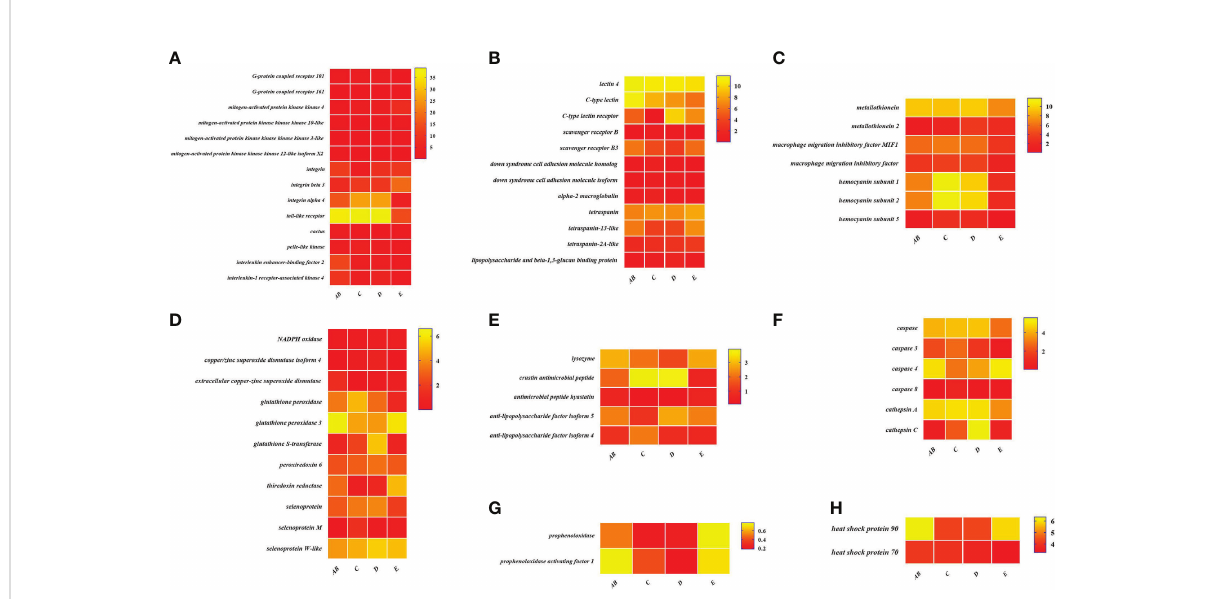
FIGURE 8 Expression patterns of immune-related genes in the hepatopancreas during the molting cycle of P. trituberculatus . (A) The genes related to signal transduction; (B) the genes related to pattern recognition proteins/receptors; (C) the genes related to other immune molecules; (D) the genes related to antioxidative enzymes system; (E) the genes related to antimicrobial peptides; (F) the genes related to apoptosis; (G) the genes related to prophenoloxidase cascade; (H) the genes related to chaperones. Notes: (1) The x -axis shows the molting stages, whereas the y -axis represents the name of genes. (2) The color represents the expression level of the gene; the lighter the color, the higher the gene expression level. (3) The expression level of immune-related genes was shown as log2 transcript per million plus one (TPM + 1).